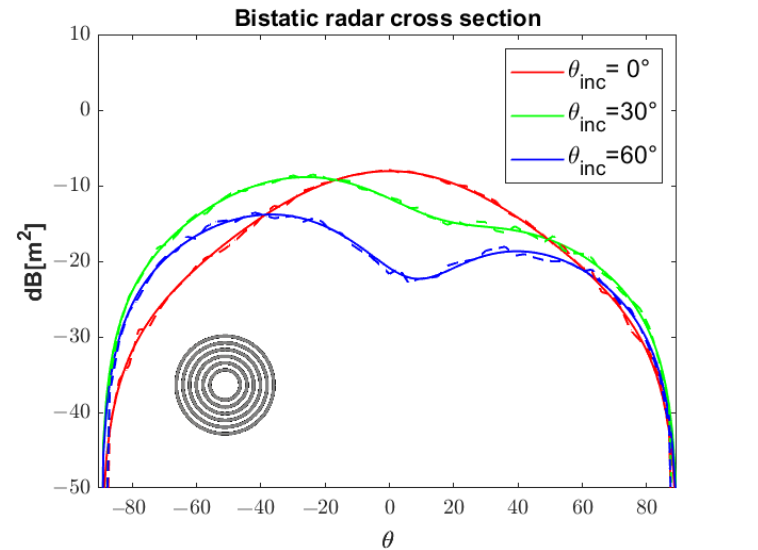
Figure 9. Bistatic radar cross section for geometry #4 (sketched in the inset) for different incidence angles θ inc . Solid line: this method; dashed line: CST Microwave